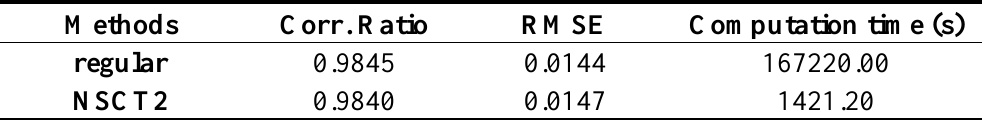
Table 2. Comparison results between the NSCT2 and regular methods.